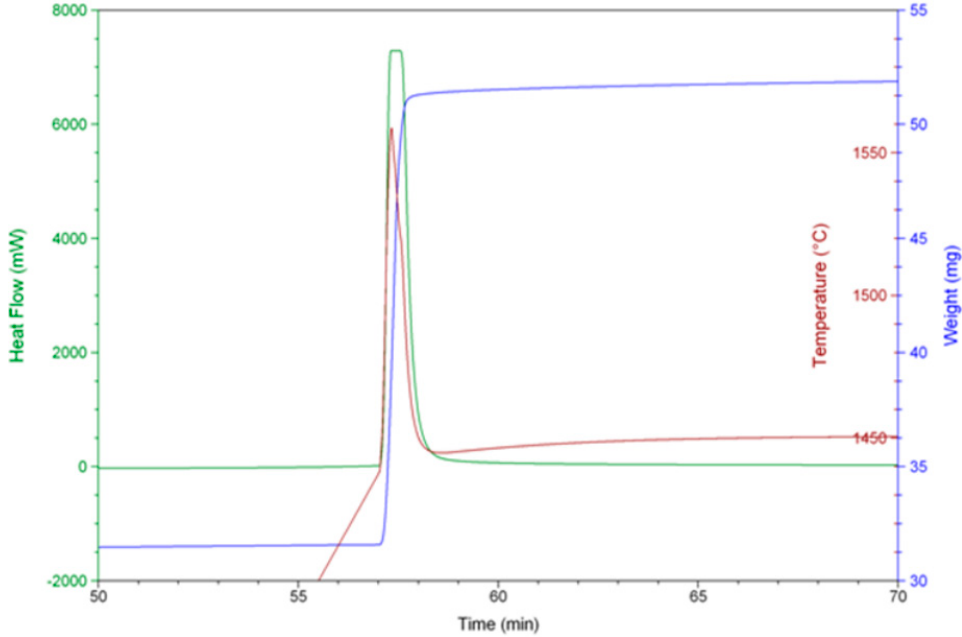
Figure 9. Temperature of 1400–1450 °C was reached before oxidizer was introduced.